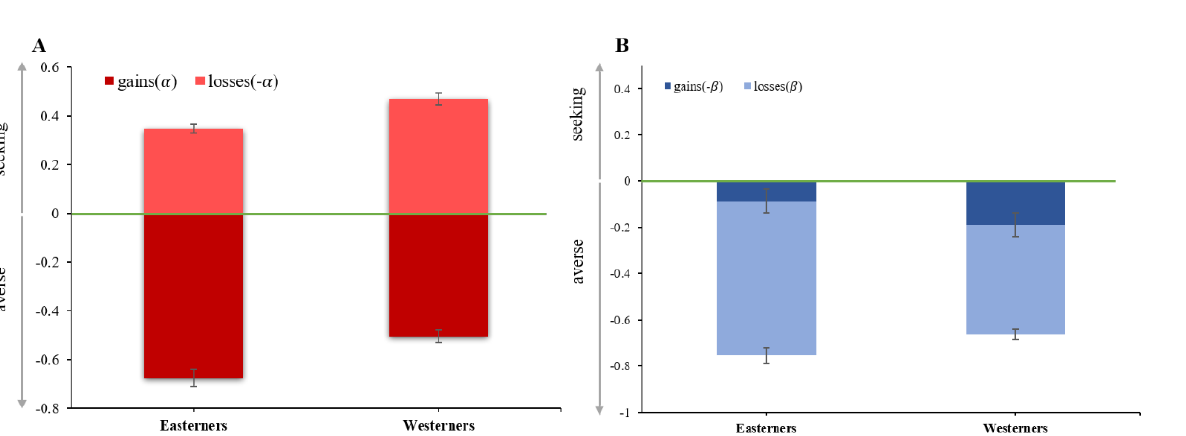
Table 1. Analysis of risk and ambiguity attitudes, including BIS and BAS scores as covariates.